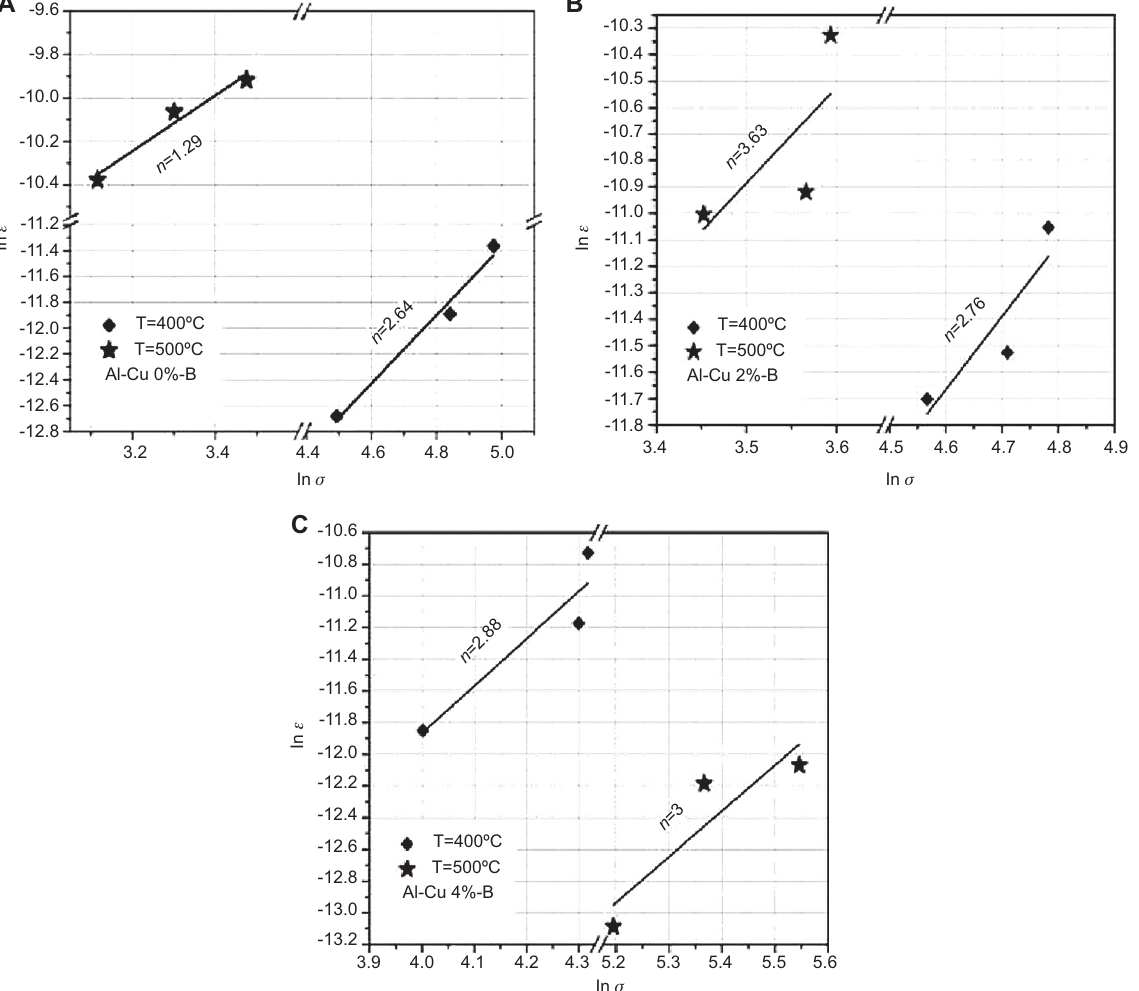
Figure 8 Graphs of secondary creep strain rate as a function of the applied stress in a logarithmic scale for the Al-Cu composite at 400 ° C and 500 ° C: (A) unreinforced Al-Cu alloy, (B) 2 wt% B, (C) 4 wt%